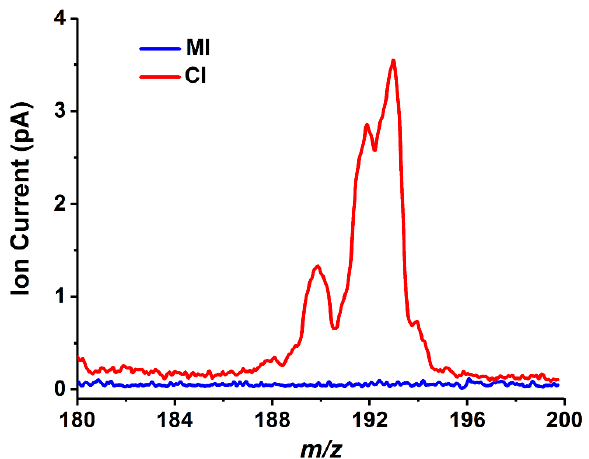
Figure 5. Typical mass spectra of 9-methylanthracene solution acquired in MI and CI experiments.